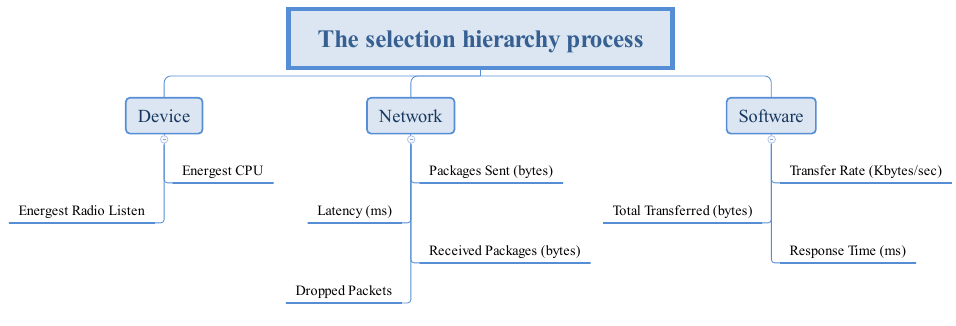
Figure 4. Metrics categorized into